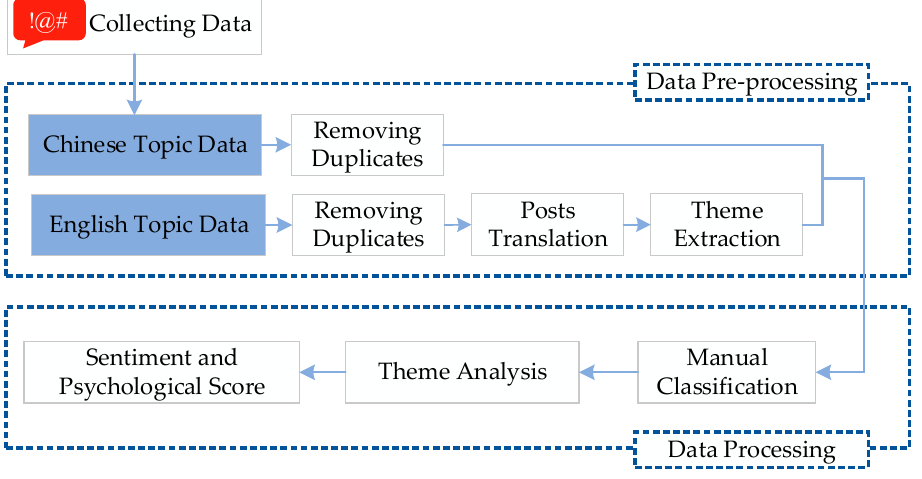
Figure 2. Architecture of the analysis process of the topic data.